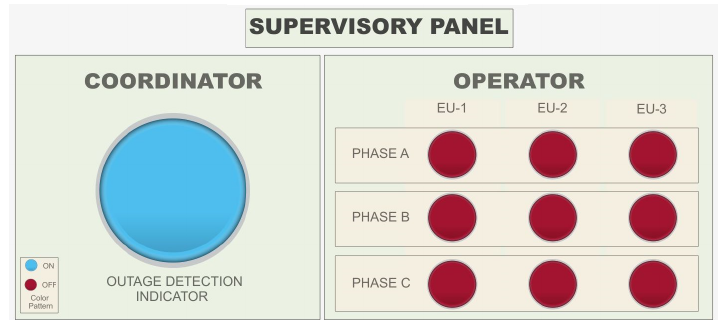
Figure 18. Supervisory Panel signaling concerning maintaining EU disconnection upon detection of the restore event.